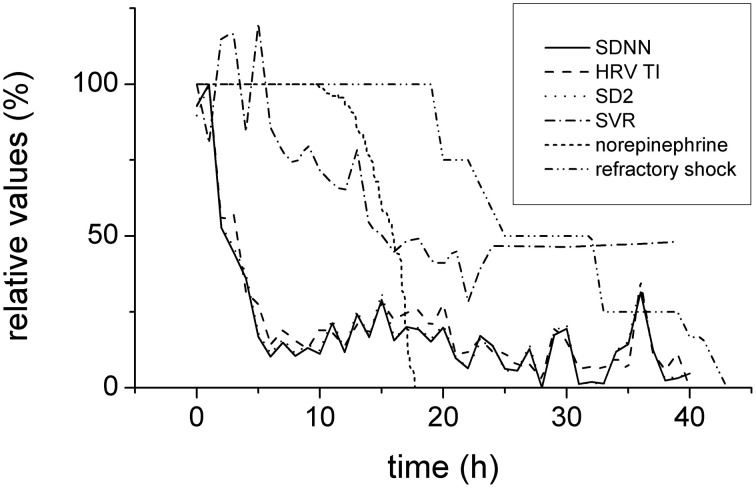
Time relationships of HRV, hemodynamics, and refractory shock development. Expressed in relative values (100% corresponds to baseline). Depression of HRV parameters (SDNN, full line, HRV TI, dashed line, and SD2, dotted line) preceded the hemodynamic instability (systemic vascular resistance, dash-and-dotted line; reverse norepinephrine dose calculated as a difference of the respective dose and baseline 100%, short-dashed line) and refractory shock/death (double-dot-and-dashed line).